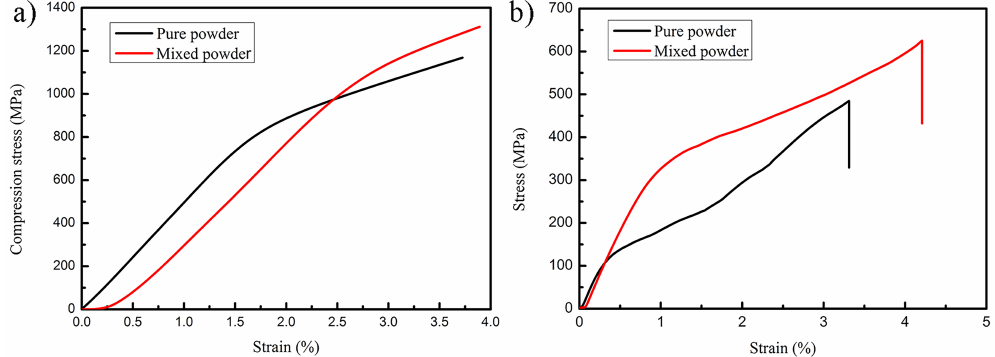
Figure 14. The stress-strain curves of BJ3DP Ti6Al4V samples: ( a ) the compression strain-stress curve; ( b ) the tensile strain-stress curve.